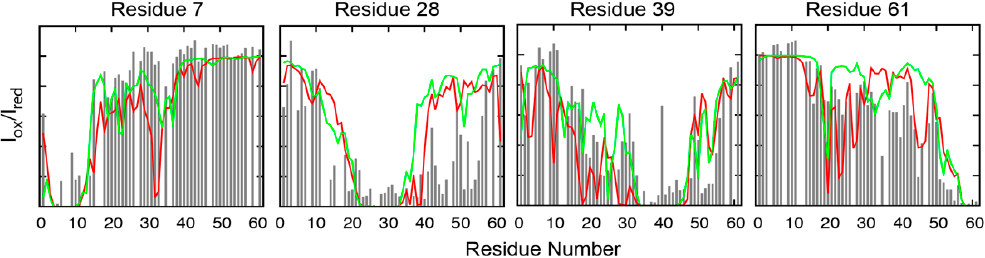
Figure 2. Calculated (lines) and experimental (grey bars) NMR Paramagnetic Relaxation Enhancement (PRE) effects induced by paramagnetic spin labelling at residues D7, E28, A39, and D61 of p53-TAD. Red and green traces were calculated from an independent control and folding REST2 simulations of p53-TAD in a99SB-disp, respectively, to evaluate the level of convergence. Control and folding simulations were initiated from helical and fully unstructured structures, respectively, and the length of REST2 simulations were 1 μ s per replica. This figure was adapted from [99]. See [99] for details on the simulation and analysis.